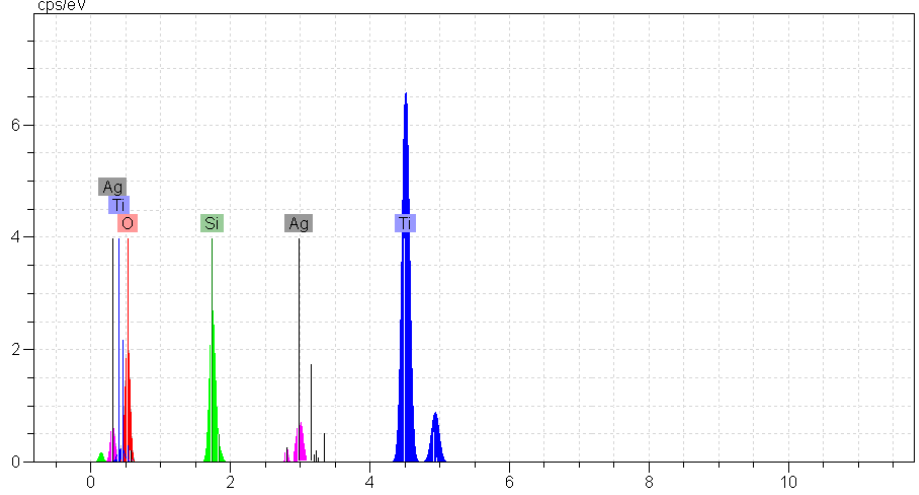
Fig. 11. EDS spectrum of the Ag NPs/TiO 2 /SiO 2 sample Fig.11 EDS spectrum of the Ag NPs/TiO 2 /SiO 2 sample